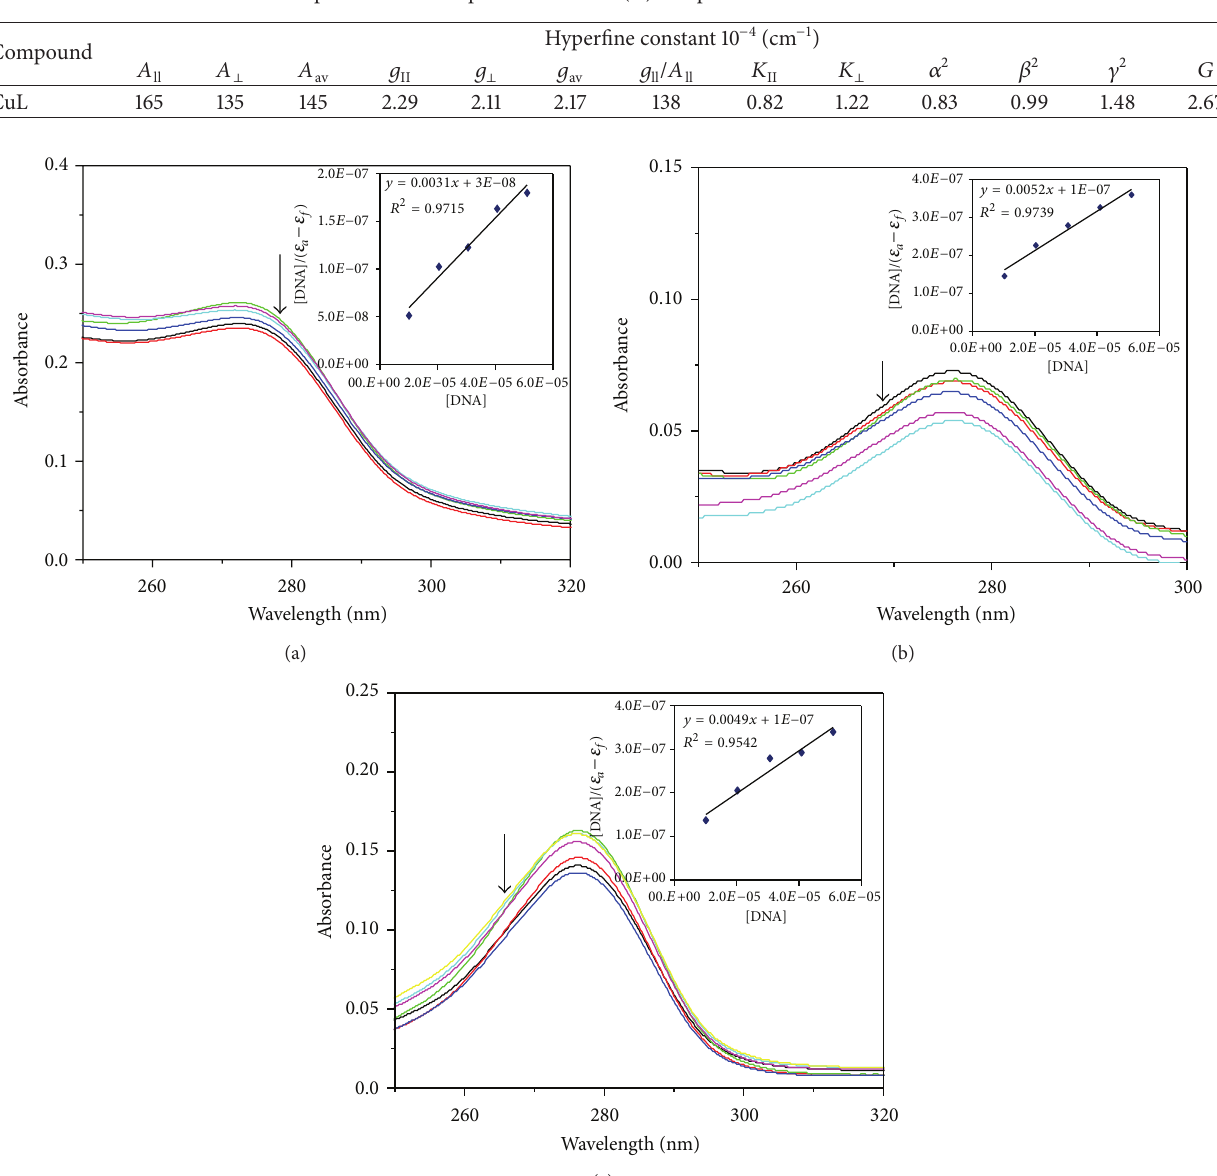
Table 2: Spin Hamiltonian parameters of Cu(II) complex in DMSO at 300 K and 77 K. Compound